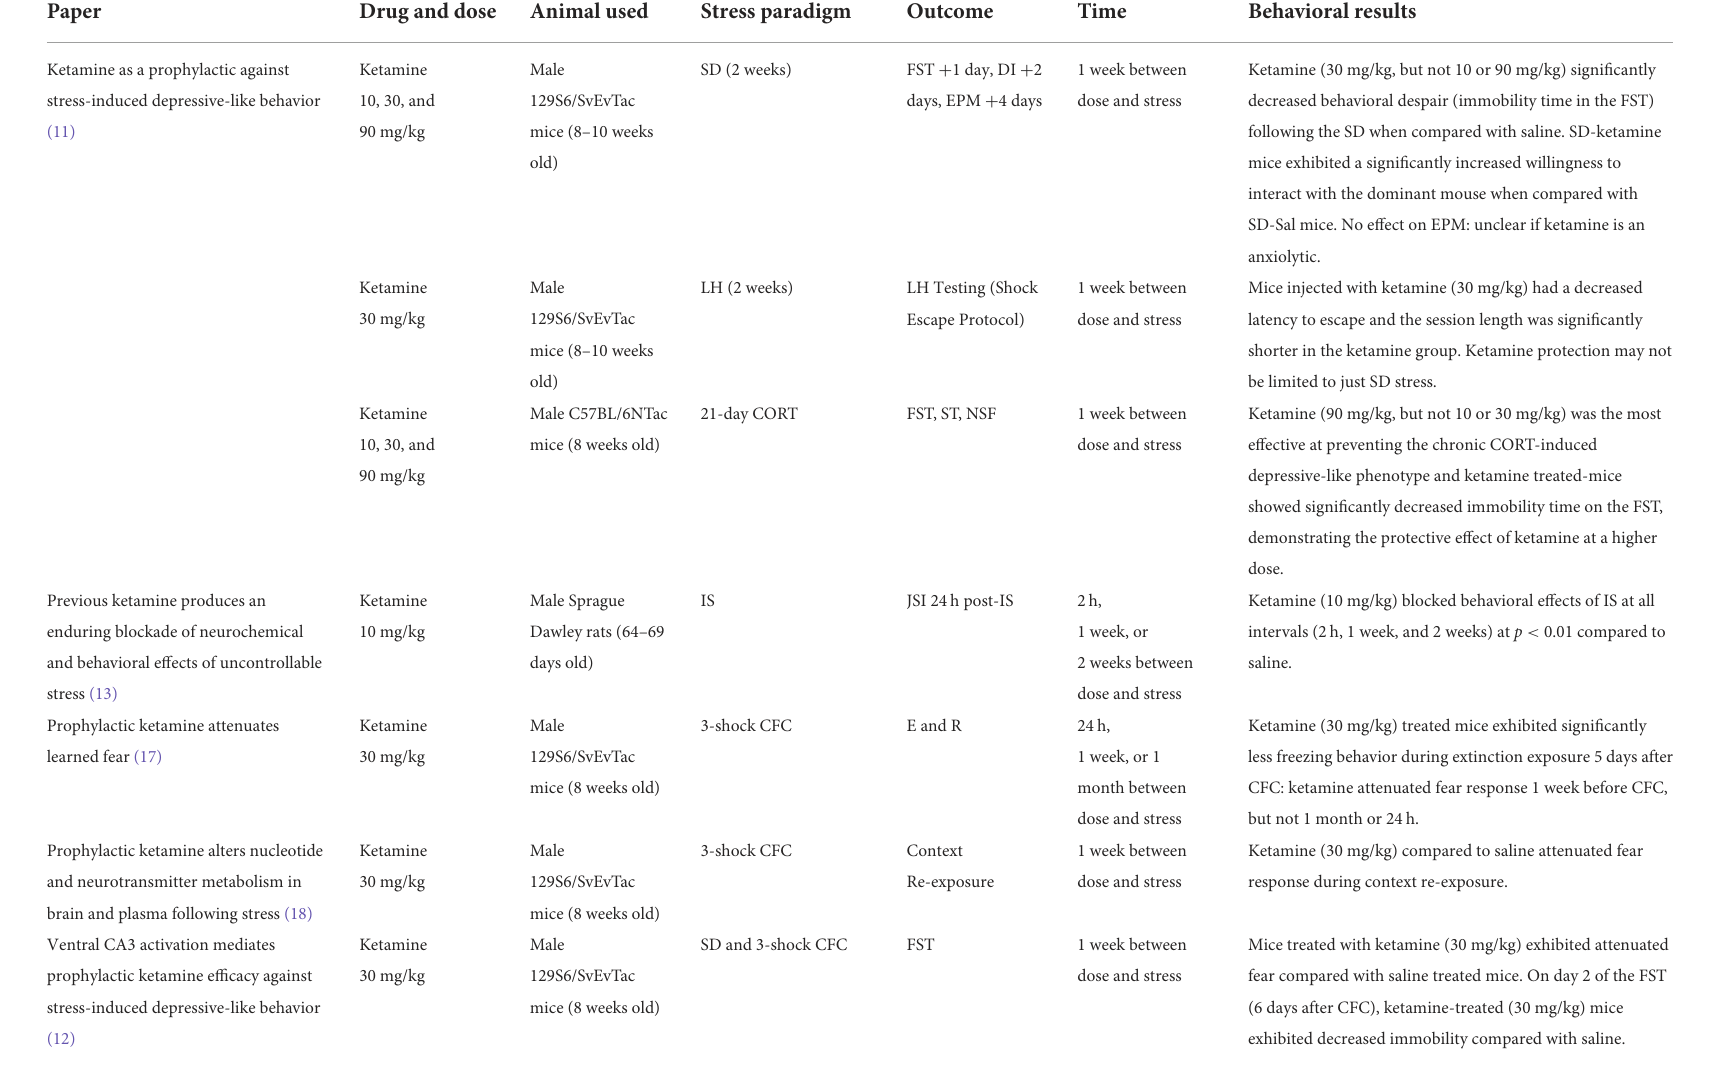
TABLE 1 The prophylactic effect of ketamine in rodent models on behavioral